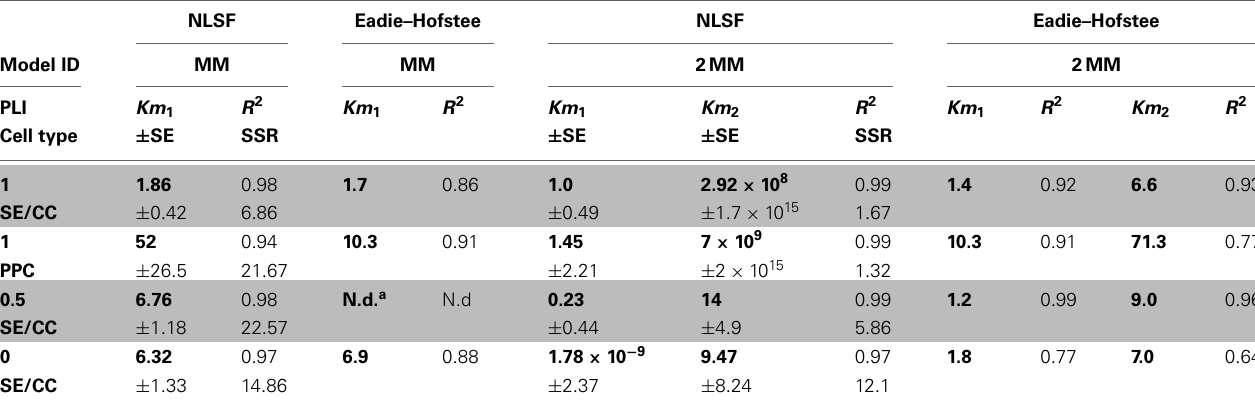
Table 1 | Summary of K m -values for sucrose uptake into SE/CCs or PPC obtained by non-linear least-square fitting (NLSF) using SIGMA PLOT 11.2 or Eadie–Hofstee